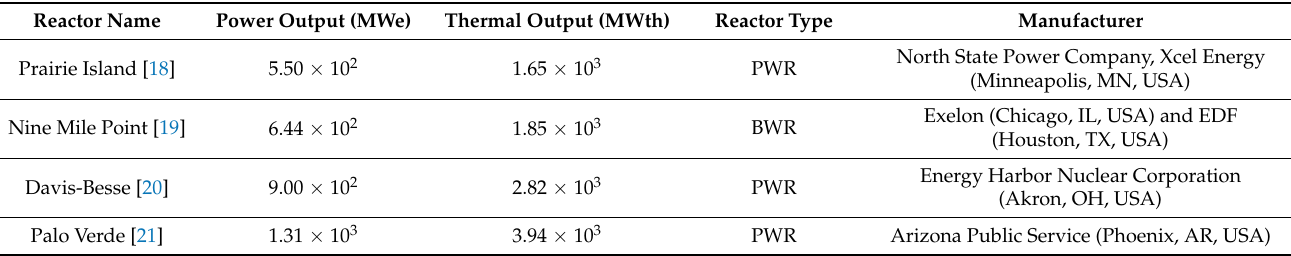
Table 1. Nuclear power plant